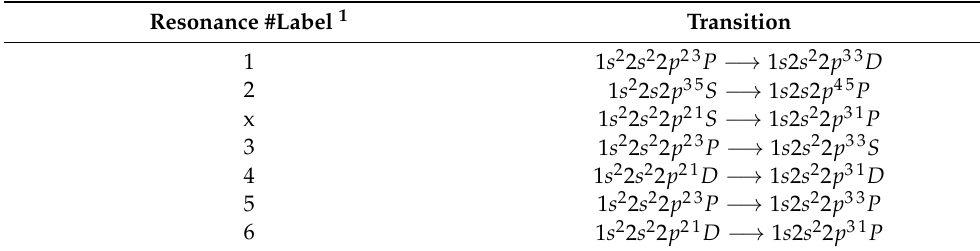
Table 3. Resonance Assignments near 400 eV photon